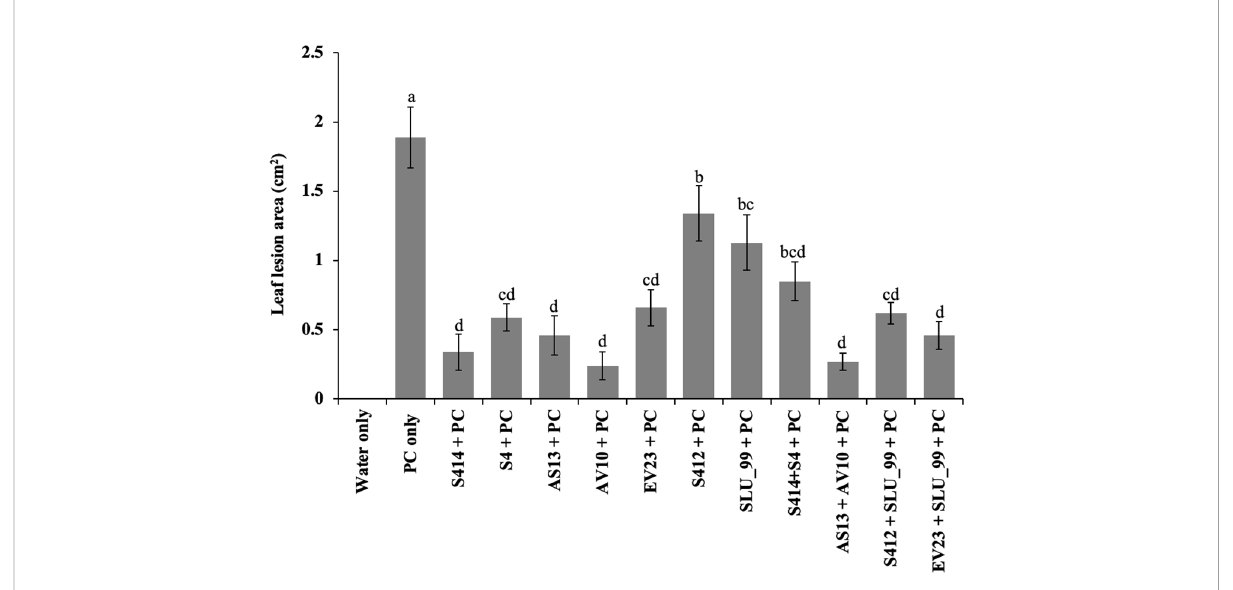
FIGURE 6 Biocontrol ef fi cacy of bacterial strains on detached taro leaves against P. colocasiae . Data are the means ± standard deviation. Means with the same letters show a non-signi fi cant difference between the treatments according to Duncan ’ s multiple ranges at P ≤ 0.05